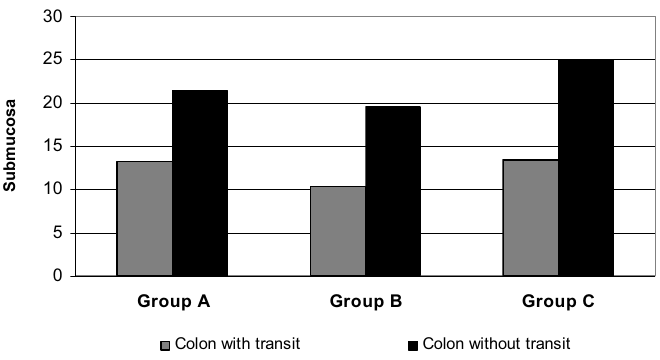
FIGURE 3 - Measurements obtained from computerized morphometry on the thickness of the colon submucosa, in the segments with and without intestinal transit in the experimental groups. Data is present as mean of micrometers. Student t test: p< 0.0004 for group A; p < 0.0001 for groups B and C.